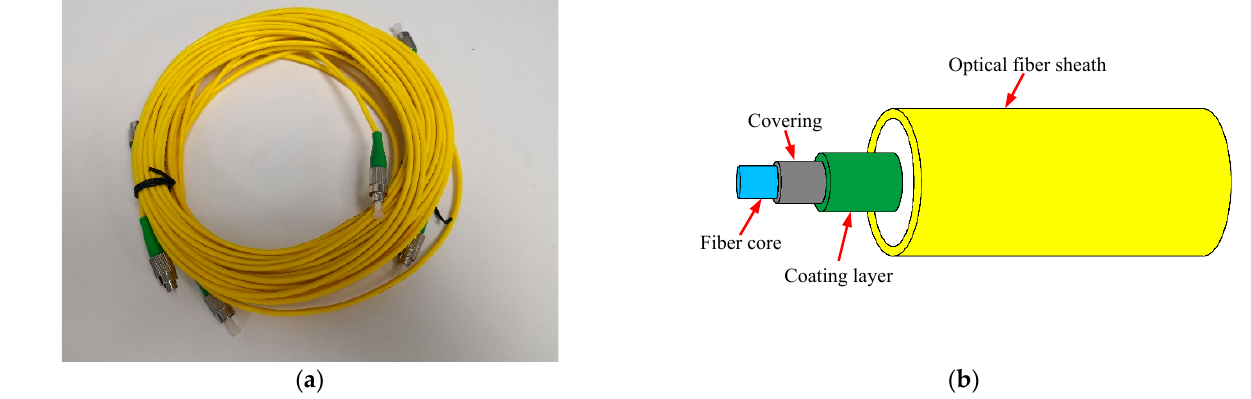
Figure 7. Optical fiber mounted with FBG sensors used in this work: ( a ) real product; ( b ) schematic diagram.